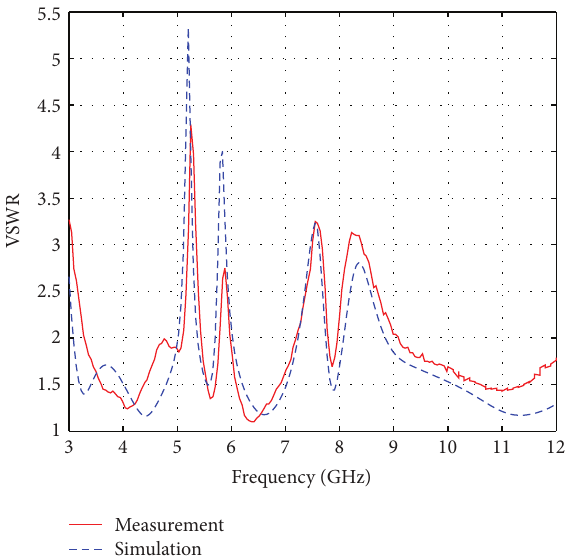
Figure 5: Simulated and measured VSWR of the quadruple band-notched UWB